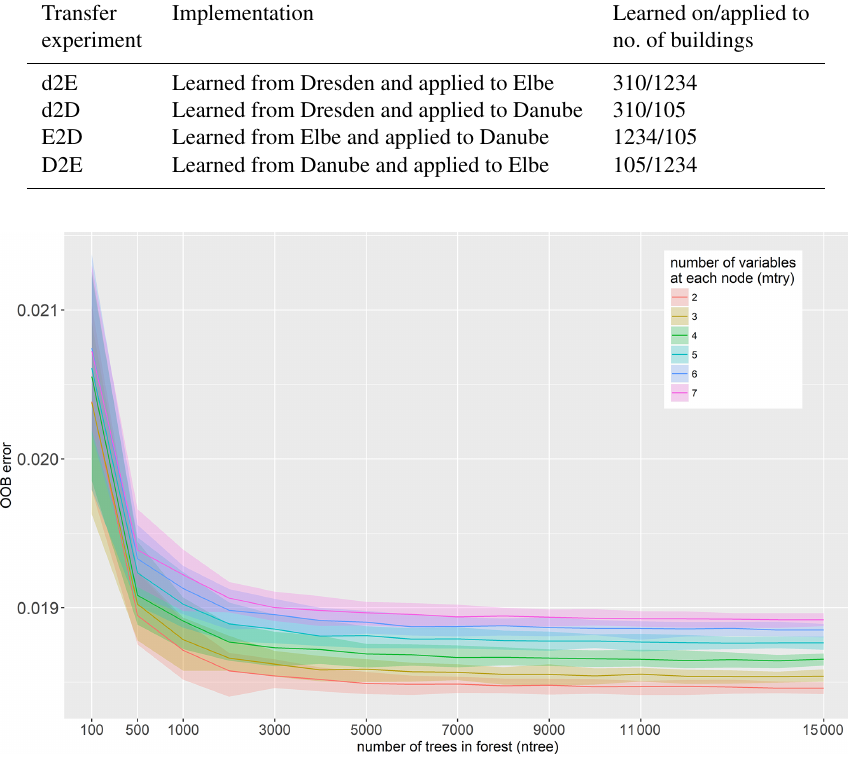
Figure 3. Out-of-bag error for variations of mtry and ntree RF parameters. Colour bands represent the variation range of OOB errors obtained from 100 bootstrap repetitions.